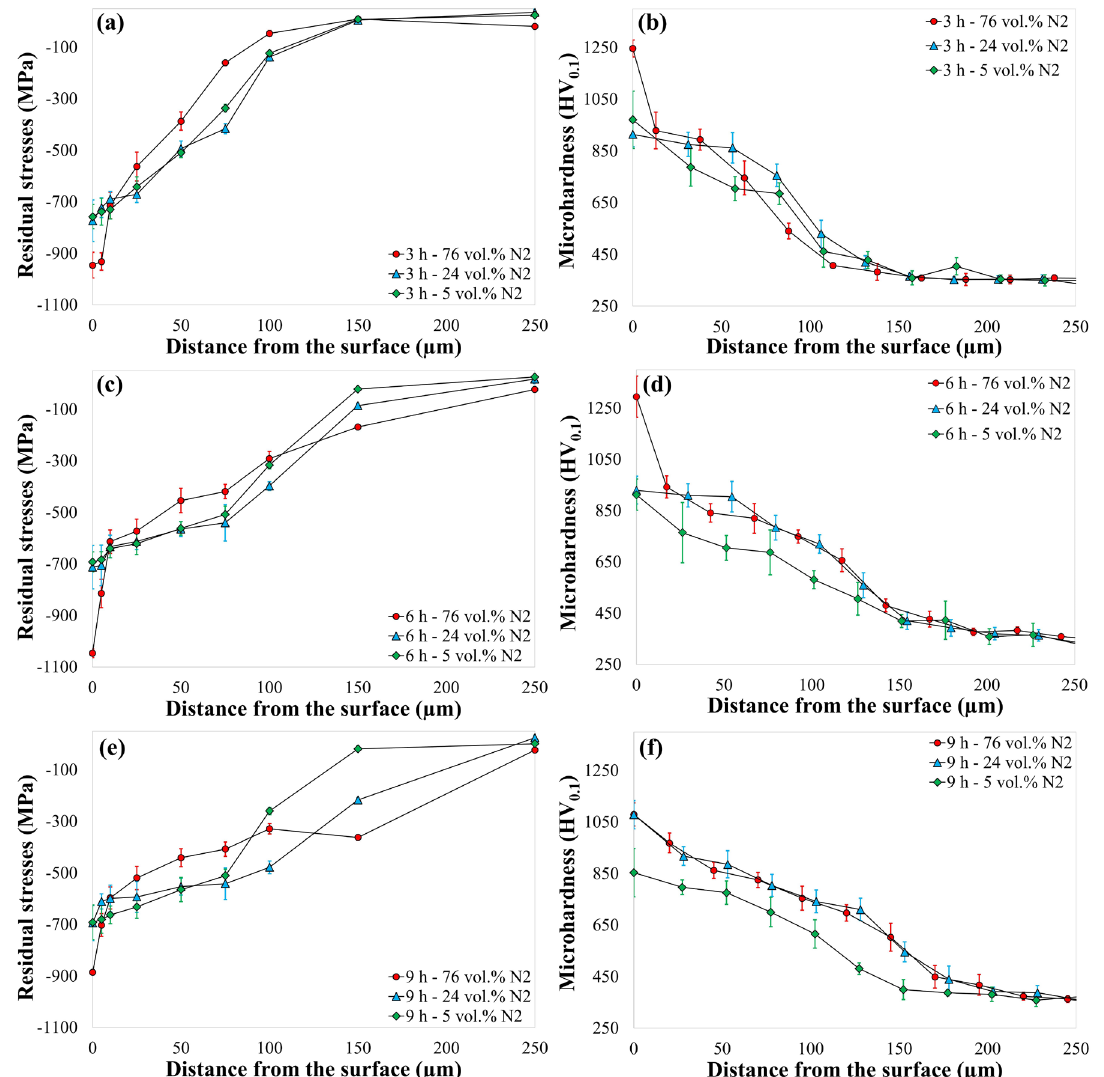
Figure 4. (a, b, c) Residual stresses profiles and (d, e, f) microhardness profiles of plasma nitrided samples with gas compositions of 5, 24, and 76 vol.%